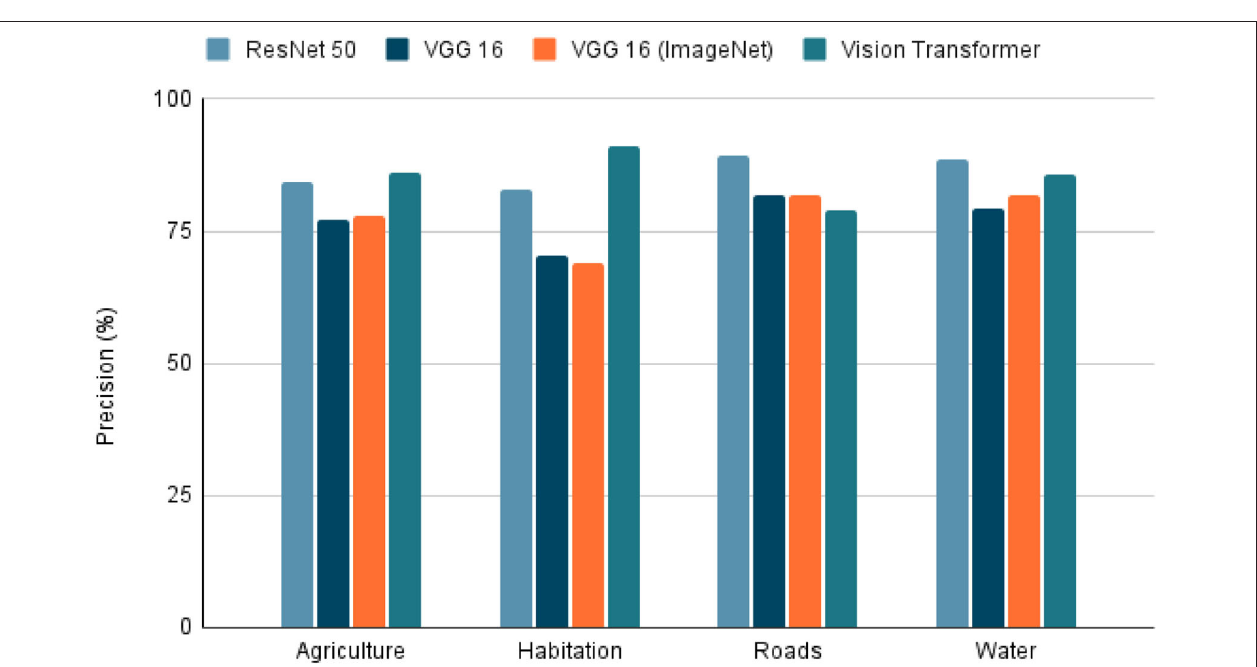
FIGURE 6 | Precision on tested models. Precision of the 4 models tested in the extraction of the 4 characteristics (agriculture, habitation, roads, whater). A highest value indicates a better performance in the classification task.